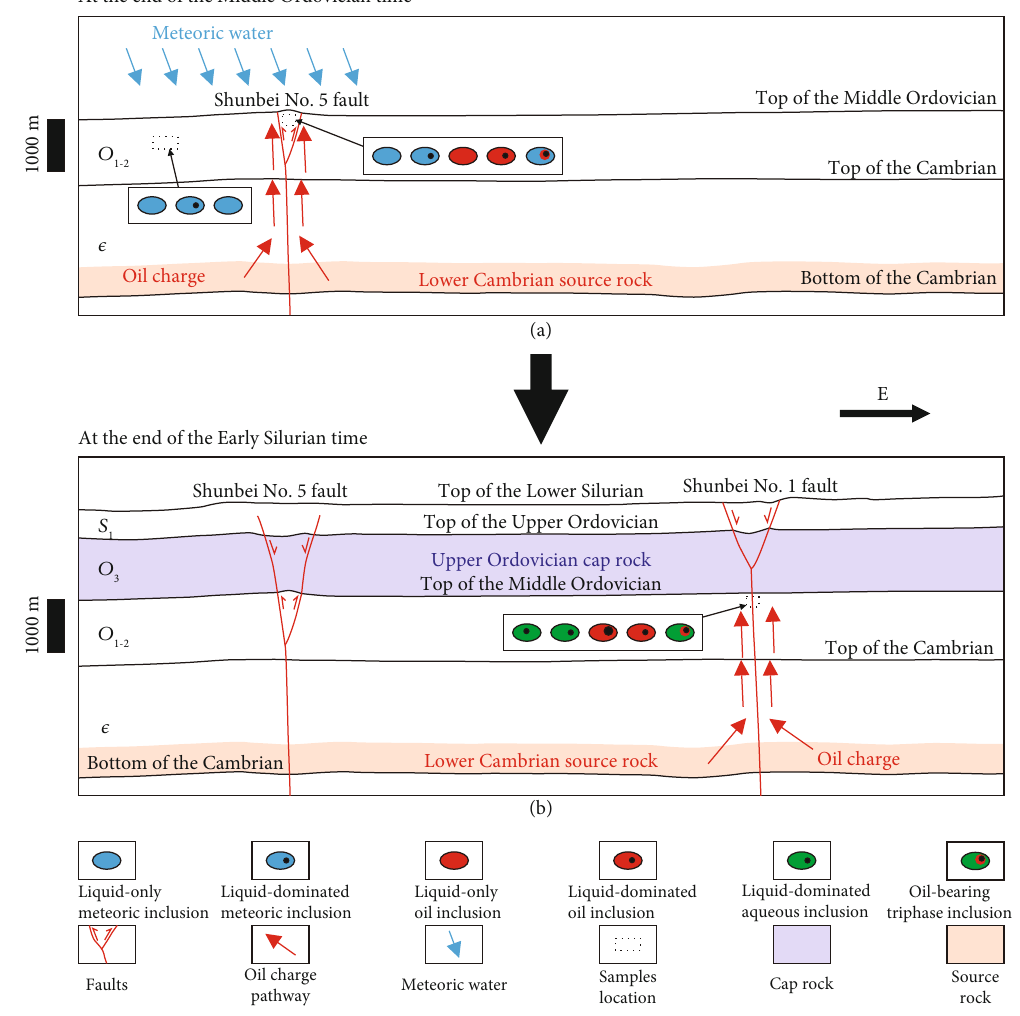
Figure 10: The model of oil charging history in the Shunbei No. 5 and No. 1 fault zones revised from the seismic section in Deng et al. [14]. The scale bar for depths is estimated from the thickness of the Ordovician strata (with a thickness of approximately